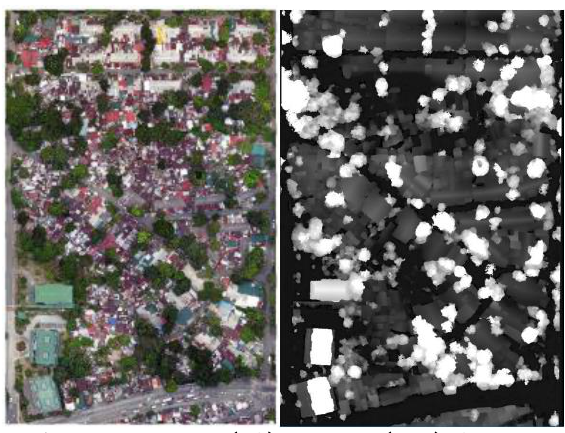
Figure 2. Orthophoto (left) and nDSM (right) of the site.